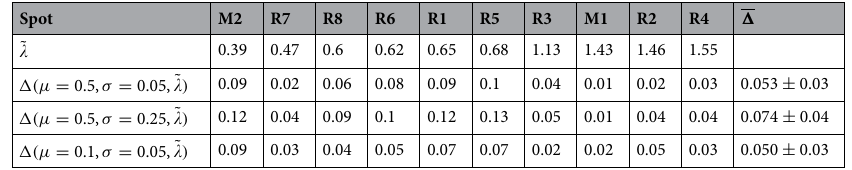
Table 2. Values of (cid:31) as obtained from Eq. (2) by minimizing the differences between numerically calculated size distributions of our decay model [see Eqs. (1) and (5)] and the field data of Ref. 11 . Values are given in ˜ (cid:31) increasing order of . The Gillespie-algorithm was run for three different combinations of the parameters of the Gaussian distribution ( µ , σ ) governing the size of particles after